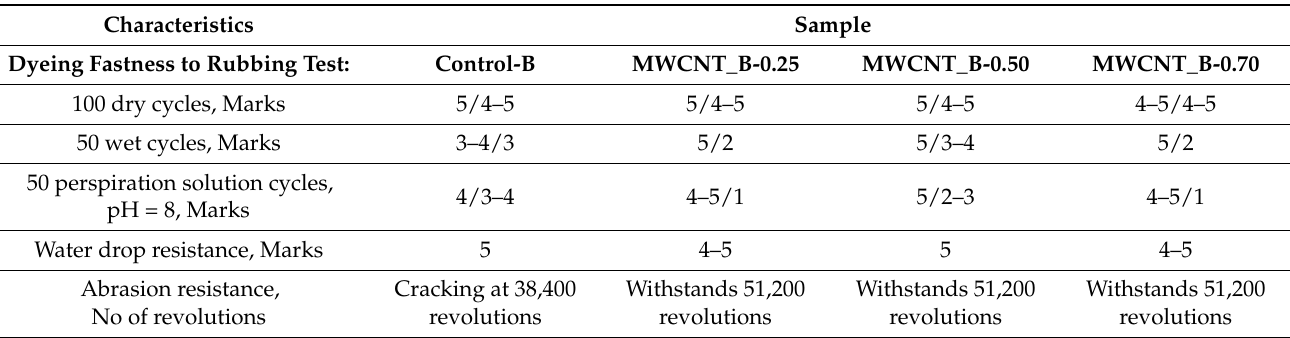
Table 5. Physical–mechanical resistance of the bovine leather surface treated with MWCNTs.